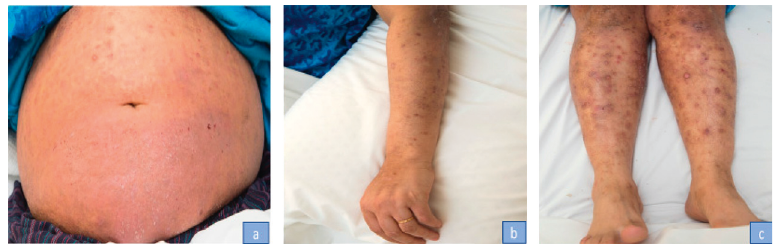
Figure 1: Extensive psoriasis lesions on the trunk (a), left arm (b), and legs (c).